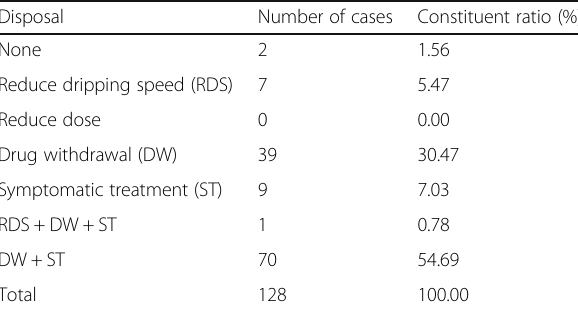
Table 8 The disposal of ADR of